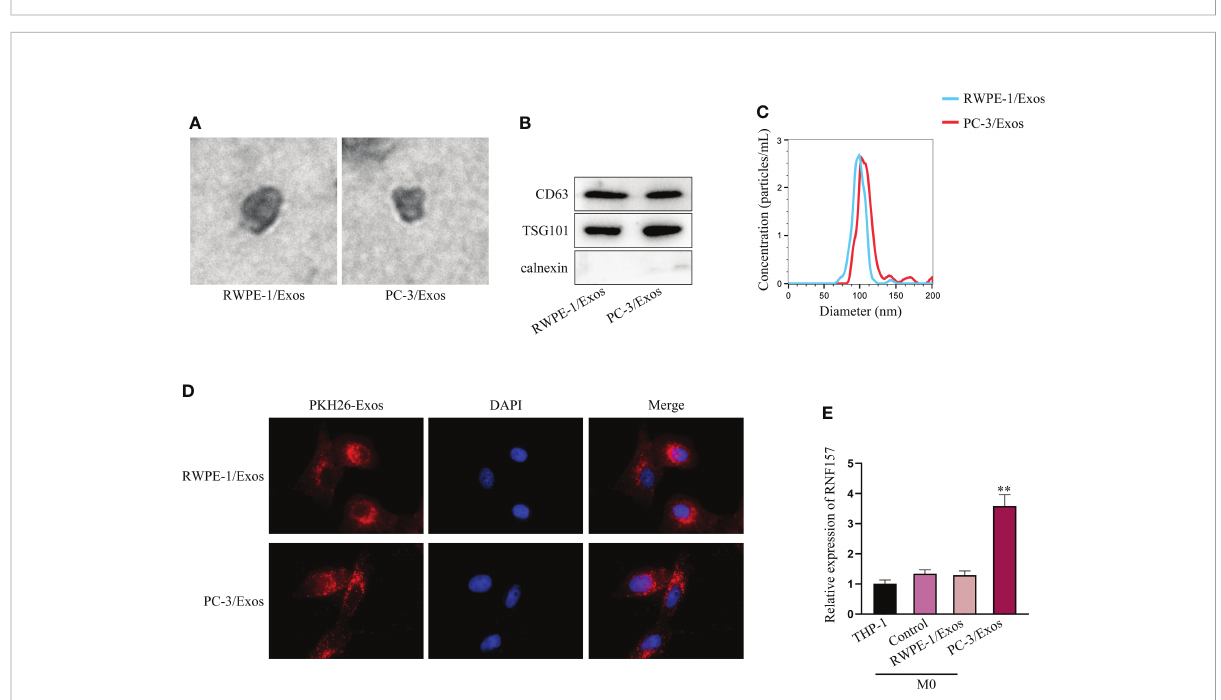
FIGURE 2 RNF157 mRNA from PCa cells could be transmitted to macrophages by exosomes. (A) Exosome morphology was observed through TEM. (B) The levels of exosomal markers (CD63 and TSG101) were tested through western blot. (C) The diameters of extracted exosomes were analyzed through NTA. (D) PKH26 was labeled to tract the exosomes and IF detected the labeled exosomes absorbed by macrophages. (E) RT-qPCR measured RNF157 mRNA level in M0 cells before and after co-culturing with exosomes from different cells. **P <